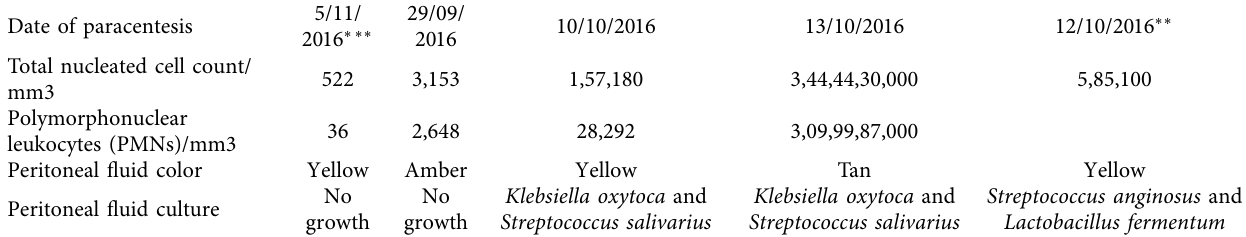
Table 1: Comparison of the ascite fluid